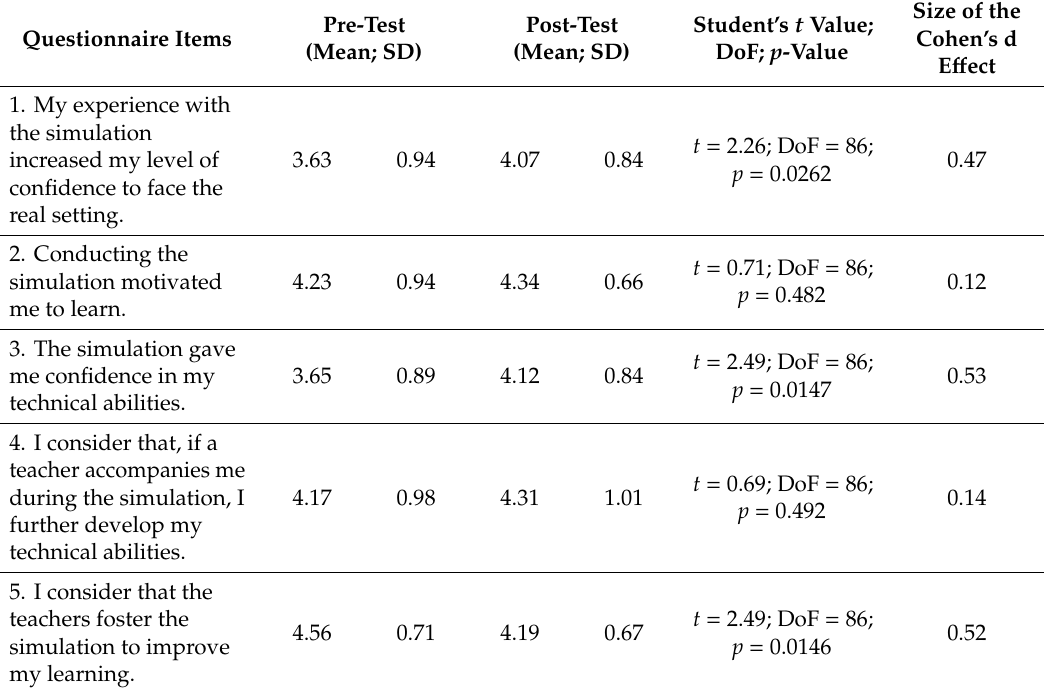
Table 2. Comparisons of the mean scores obtained in the pre-test and in the post-test. Module on confidence and